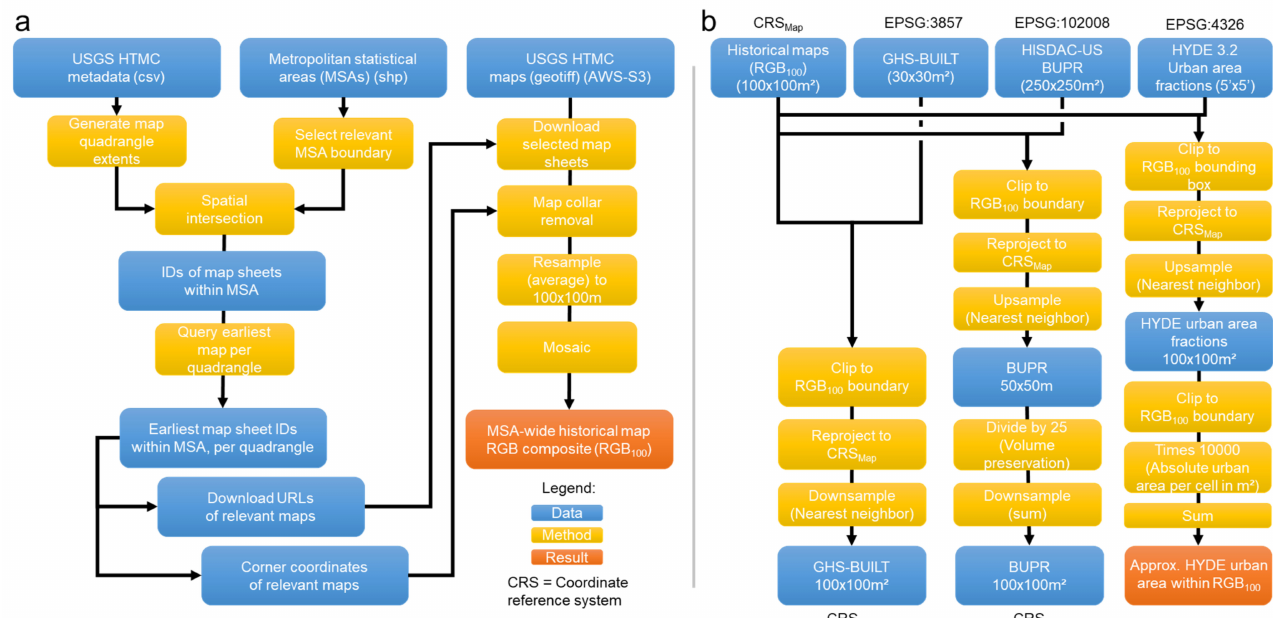
Figure A2. Preprocessing workflows. ( a ) The steps performed to generate spatially aggregated composites of RGB signals from historical maps for the Atlanta and Boston metropolitan areas. Panel ( b ) illustrates the reprojection and resampling steps to transform the historical map data, HISDAC-US, HYDE, and the GHSL into common grids. More specifically, the HISDAC-US based building densities are resampled from a 250 × 250 m 2 grid to the target resolution of 100 × 100 m 2 , using an intermediate resolution of 50 × 50 m 2 , to keep additional uncertainty introduced during resampling to a minimum. Similarly, the HYDE urban area fractions, available in a 5 (cid:48) × 5 (cid:48) grid, are resampled to 100 × 100 m 2 , and urban area fractions are proportionally re-allocated in the target grid to keep the effects of grid cells overlapping the study area boundaries to a minimum.